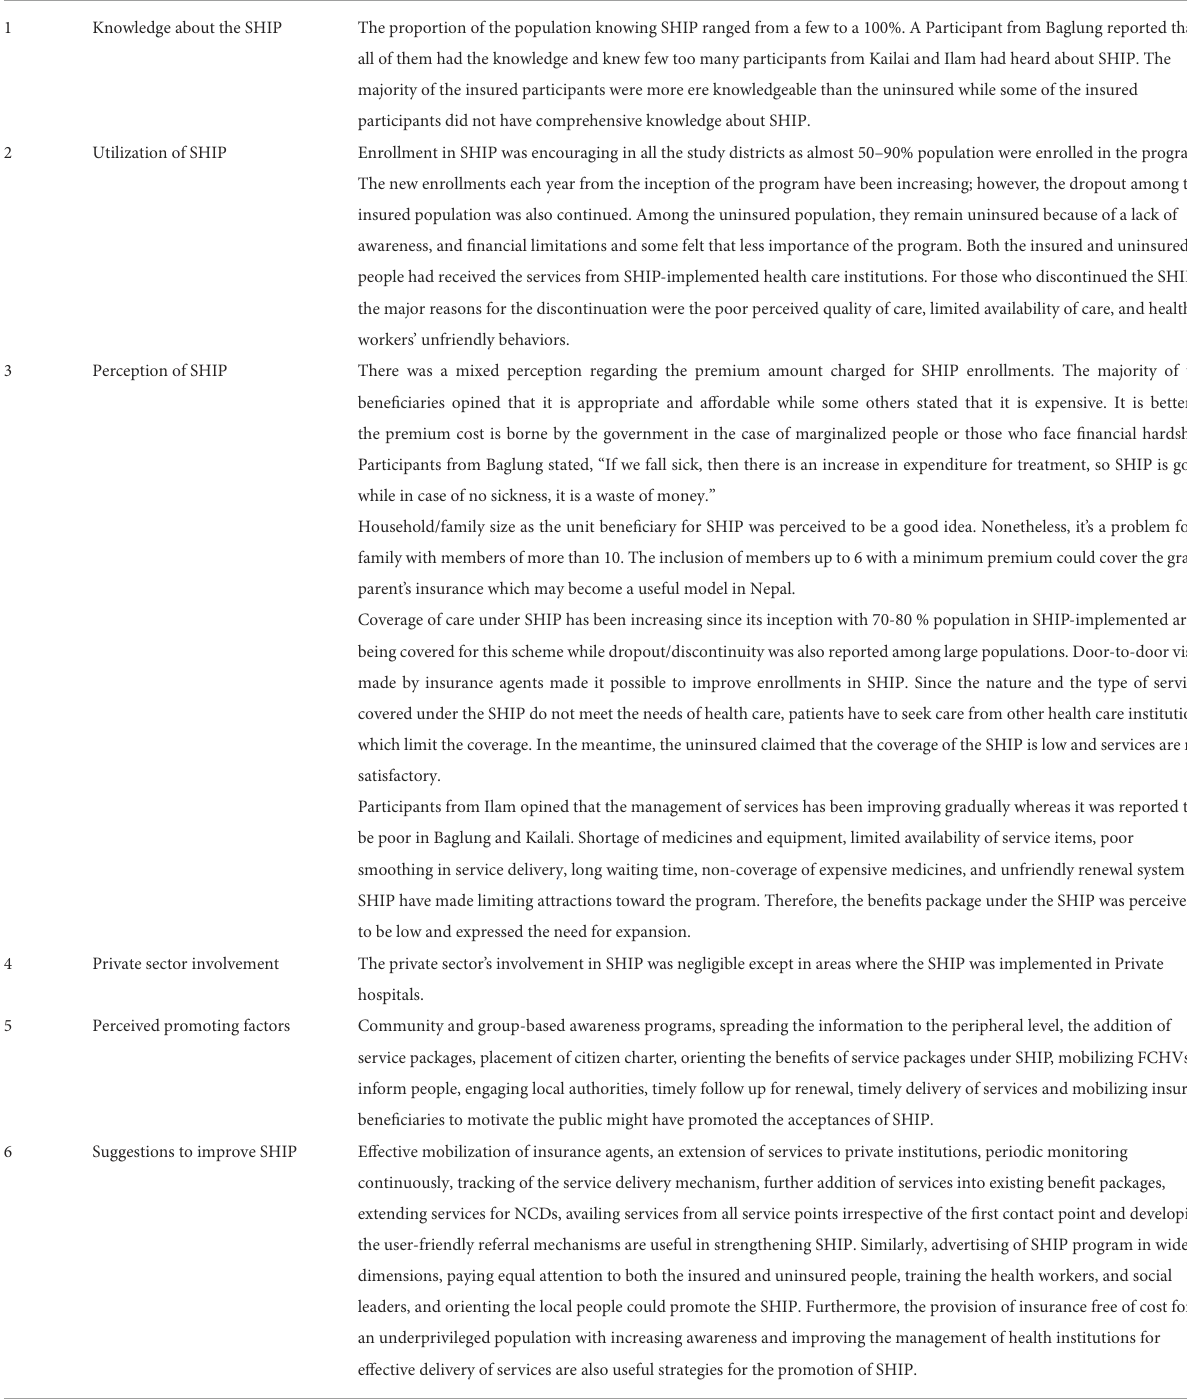
TABLE 7 Summary findings of the beneficiaries (insured and uninsured) (qualitative).